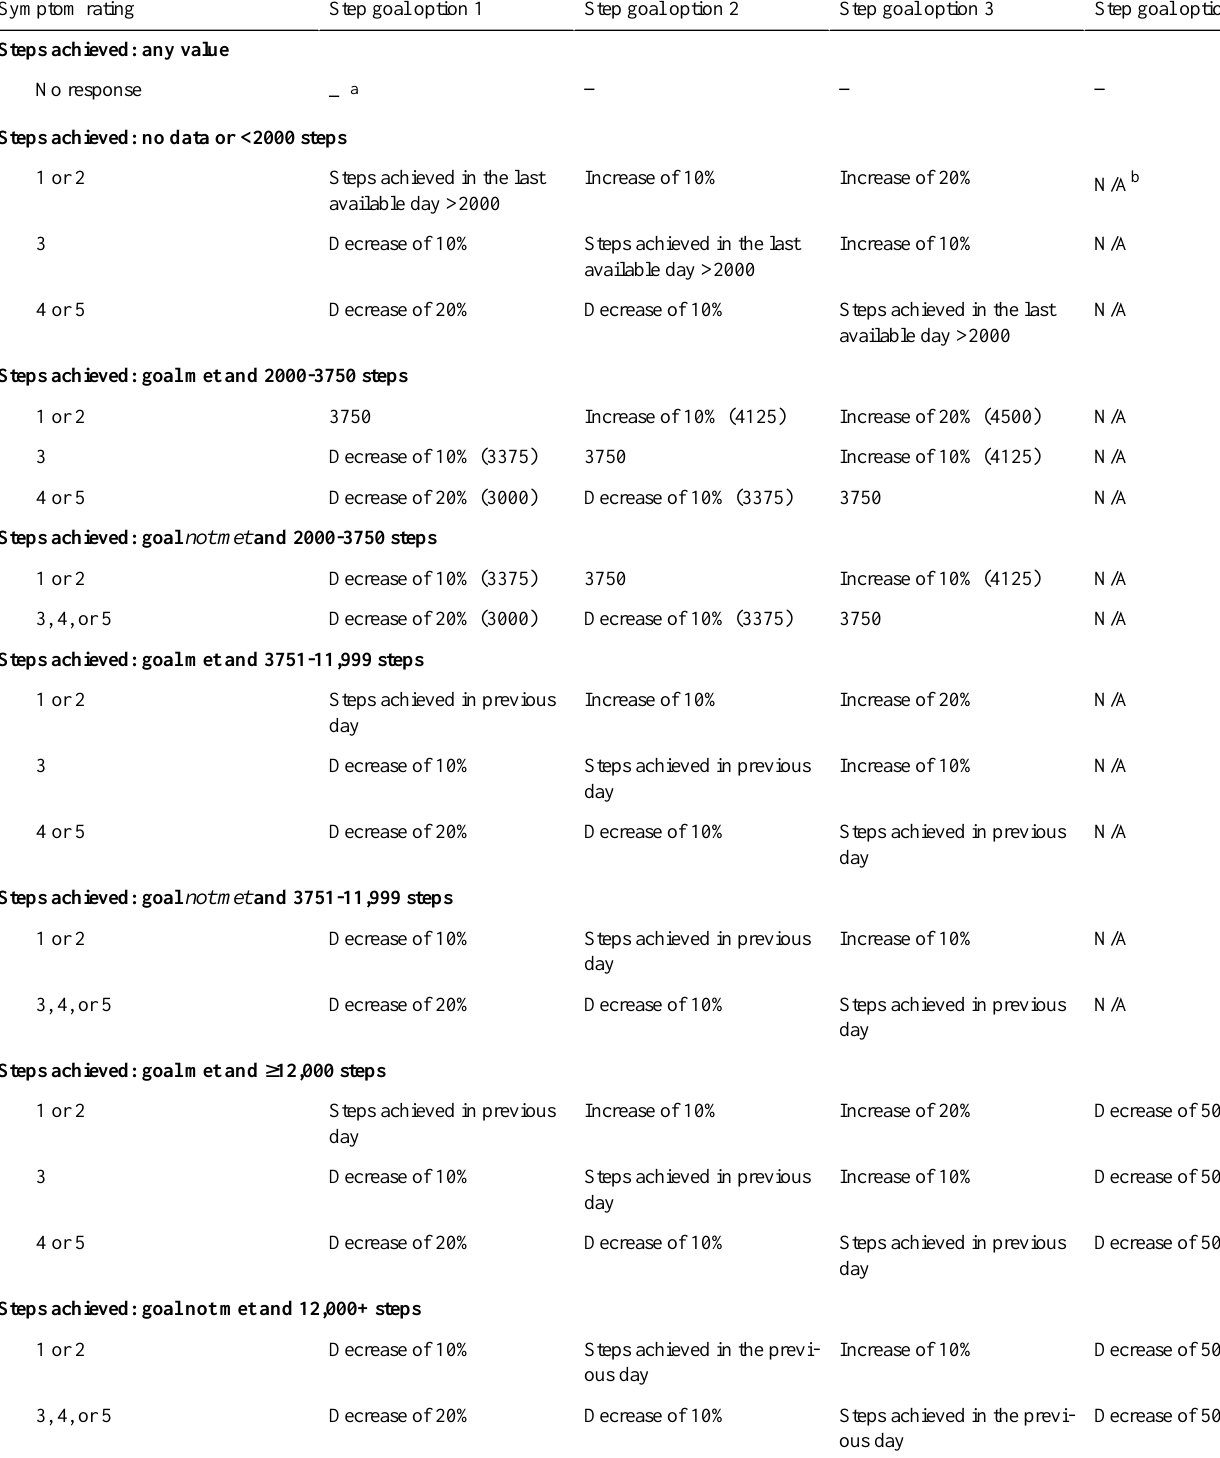
Table 3. Daily step goal